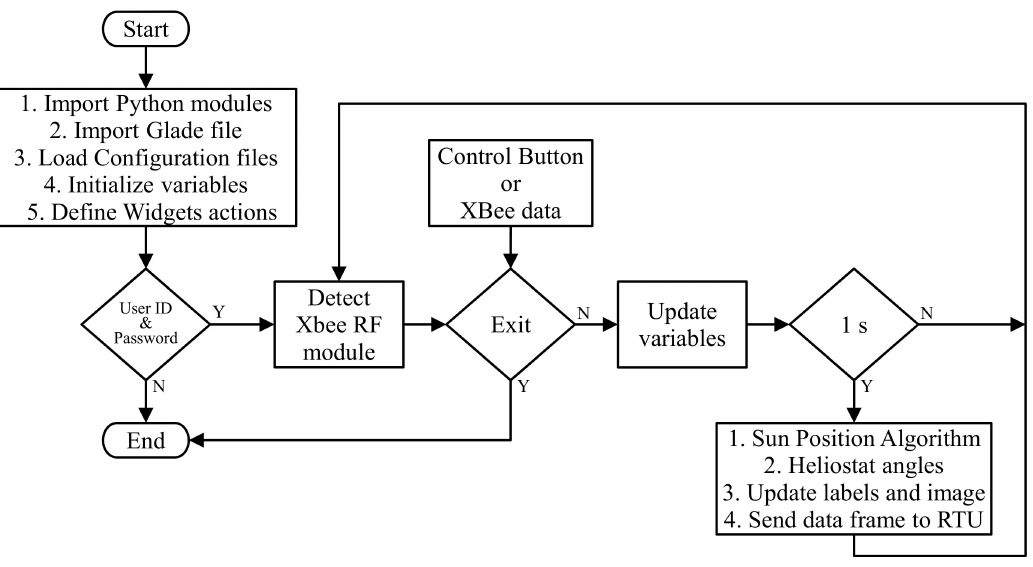
Figure 3. Algorithm of the graphical user